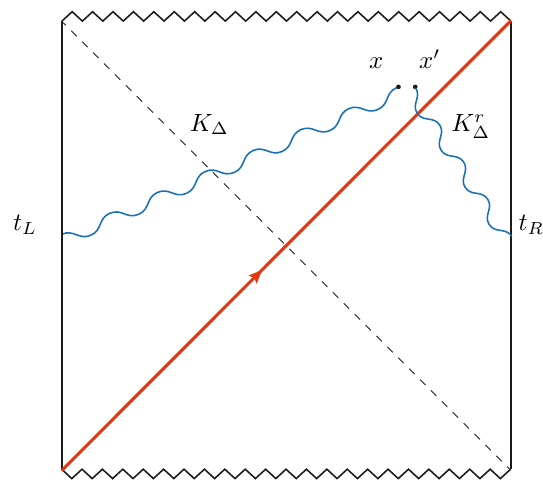
Figure 5. Schematically the ANE is given by the product of a boundary-to-bulk propagator coming from the left CFT and a retarded boundary-to-bulk propagator coming from the right one. Only the latter crosses the positive energy shock and undergoes a time